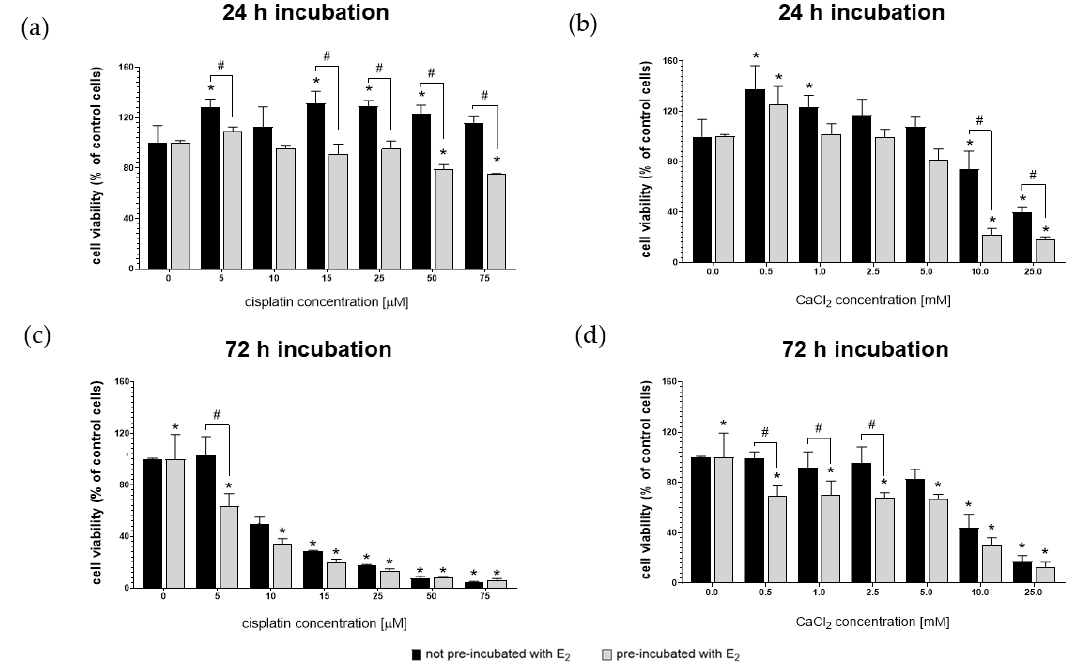
Figure 2. MDAH-2774 cells viability measured by the MTT assay after 24 h ( a , b ) and 72 h ( c , d ) incubation in increasing cisplatin ( a , c ) and CaCl 2 ( b , d ) concentrations. Notes: (mean ± SD) N = 3, * p < 0.05 compared to control, # p < 0.05 compared between different pre-incubation conditions.